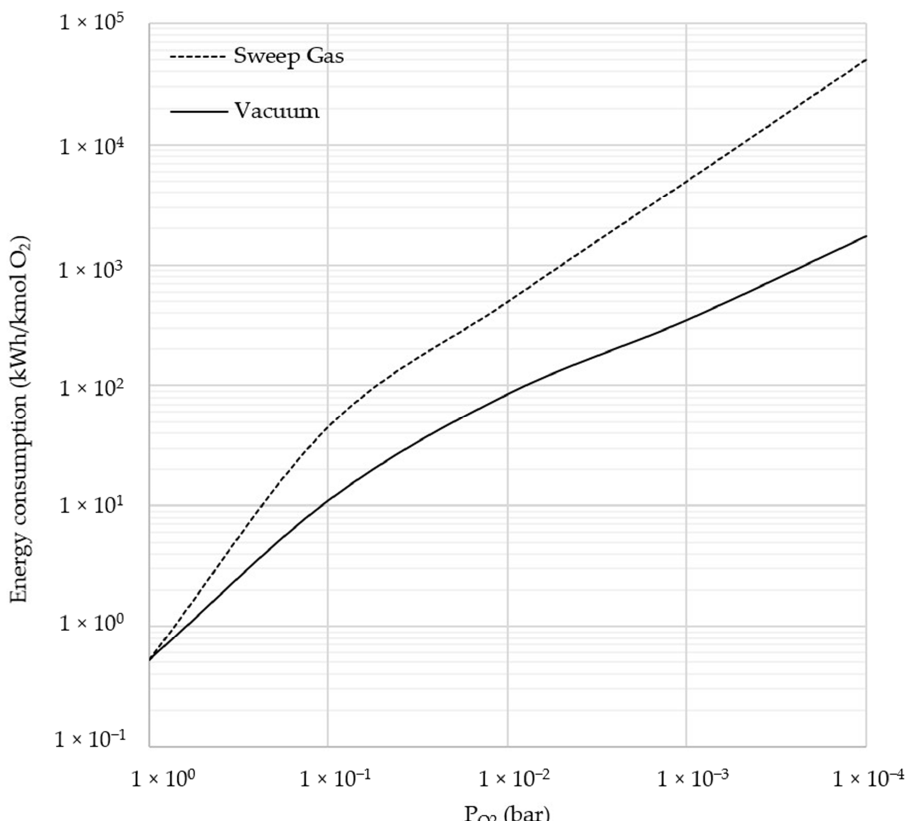
Figure 8. Energy consumption per mole of oxygen released to the atmosphere as a function of oxygen partial pressure (P O2 ). The dotted line represents the use of sweep gas with different purities under constant atmospheric pressure. The solid line shows the use of different vacuum pressures without sweep gas.